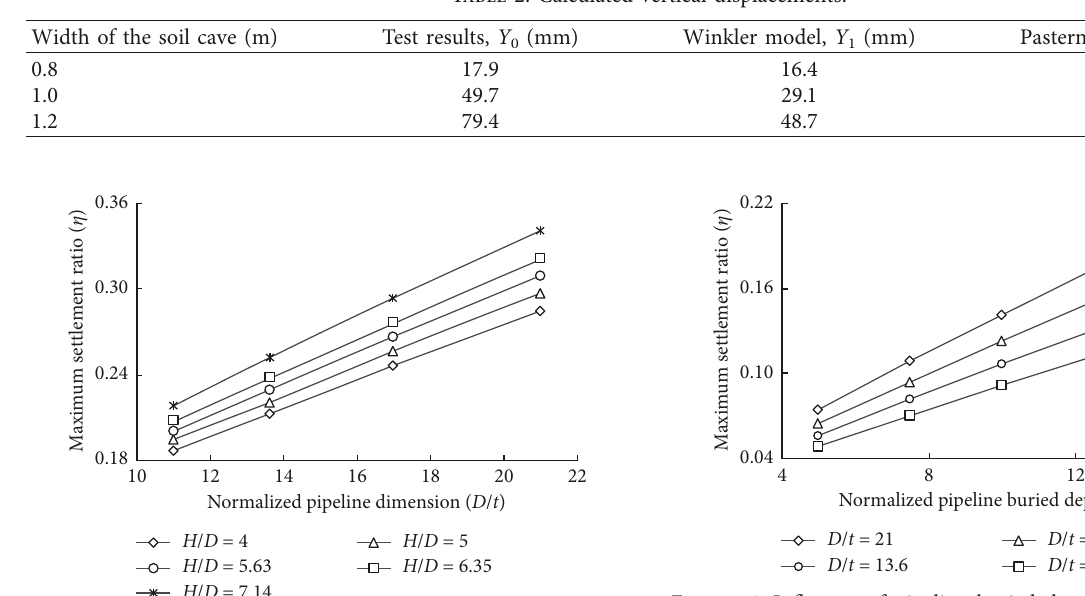
Table 2: Calculated vertical displacements.